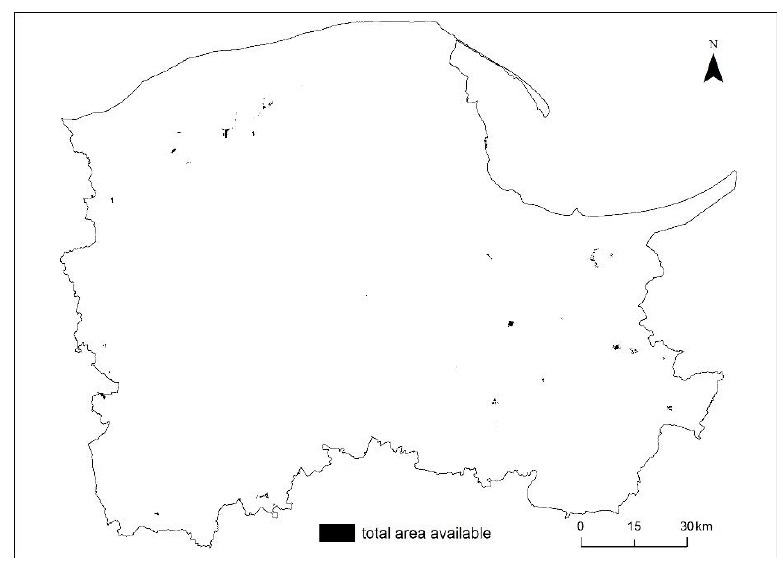
Figure 7. Area available for the development of aeroenergy in the Pomerania Voivodeship (own study).